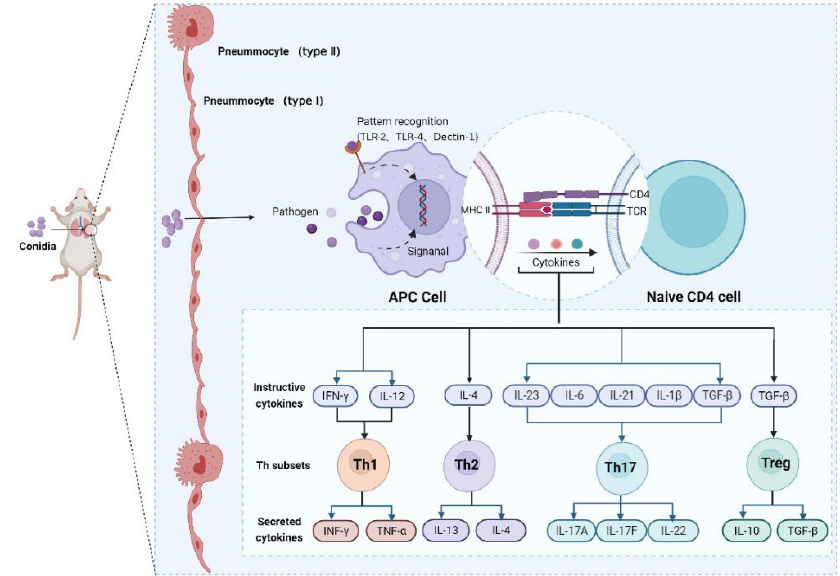
Figure 10. Patterns of immune responses in mice infected with M. gypseum . APCs recognize M. gypseum conidia through receptors, triggering innate immune response and secreting pro-inflammatory cytokines. The pro-inflammatory cytokines induce T cells to proliferate and differentiate into Th1, Th2, Th17, and Treg cells, and produce corresponding cytokines to regulate immune responses. TCR activate T cells after binding to antigen-carrying MHC II, and finally trigger a series of immune responses, such as antibody production.